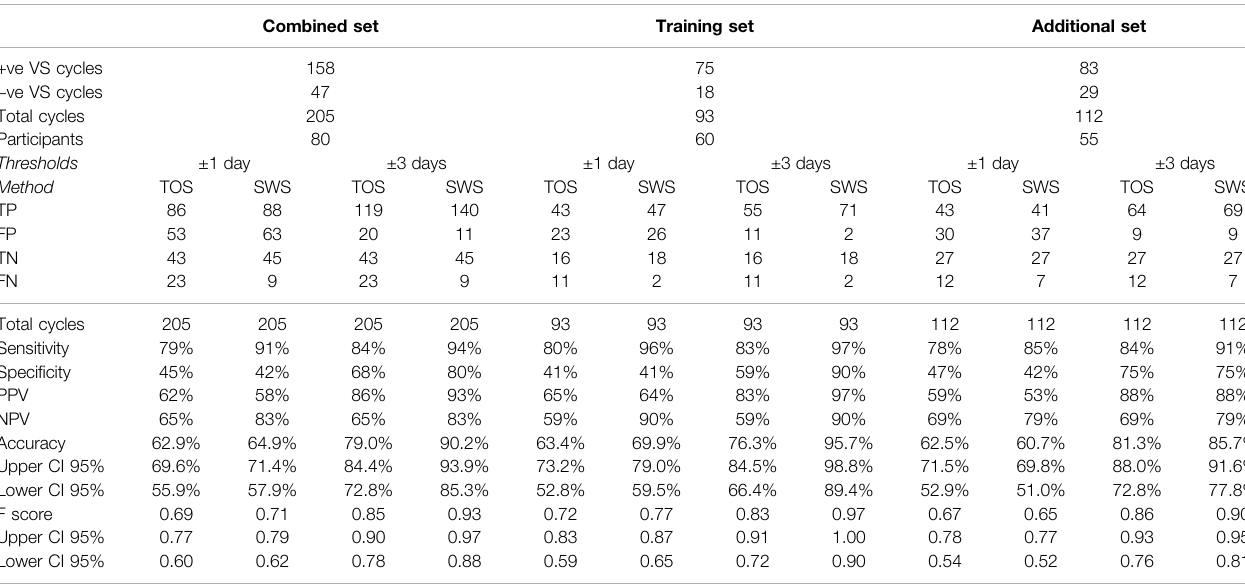
TABLE 5 | Threshold method results for TOS and SWS compared with VS for data sets.